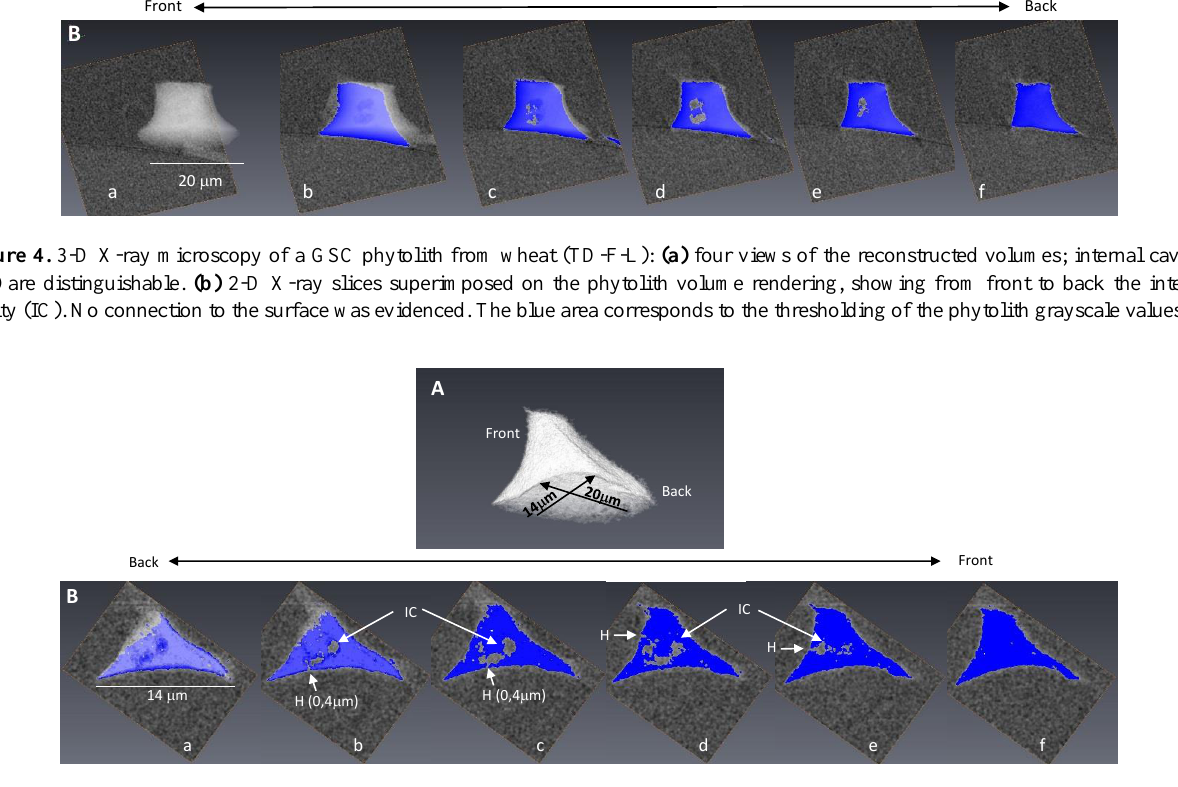
Figure 5. 3-D X-ray microscopy of a GSC phytolith from wheat (TD-F-L): (a) reconstructed volume. (b) 2-D X-ray images from back to front of the phytolith showing the internal cavity (IC) and its connection to the surface, forming holes (H). The blue area corresponds to the thresholding of the phytolith grayscale